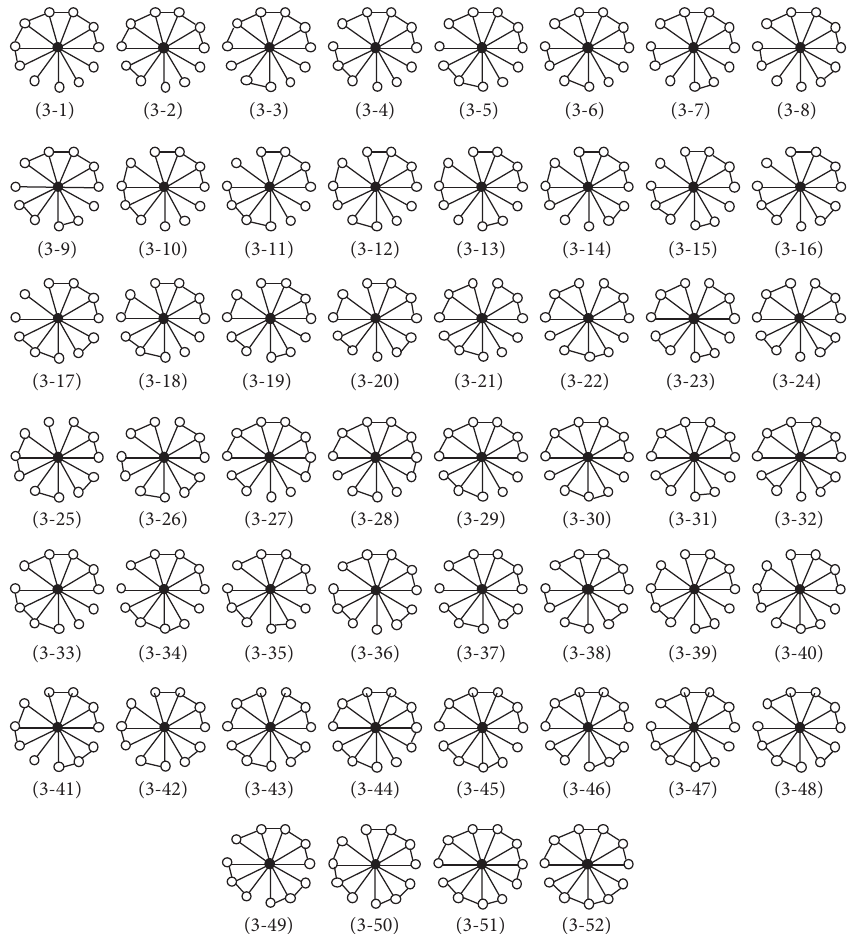
Figure 3: Vertex v is a 11-vertex, the various cases of f